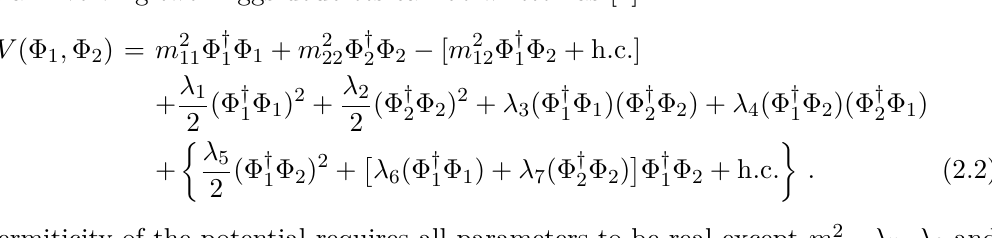
Table 1 . Yukawa couplings of the h , H and A bosons to quarks and leptons in the Type-I 2HDM. potential involving two Higgs doublets can be written as